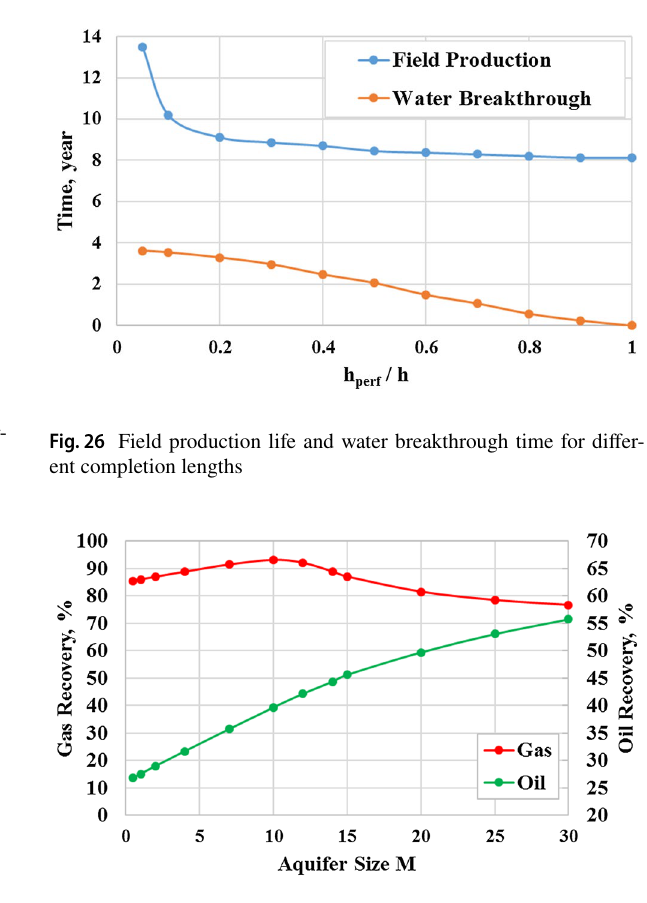
Fig. 24 Gas and oil recoveries for different completion lengths